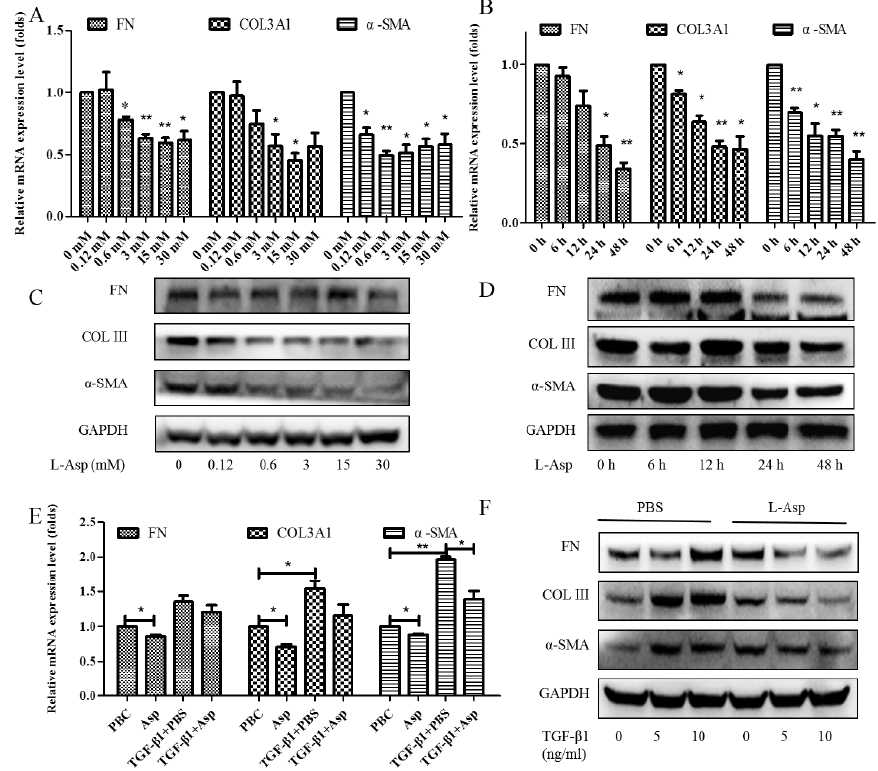
Figure 2. Inhibitory effect of Asp on HSCs activation in vitro. ( A – D ) LX-2 cells were treated with Asp in different concentrations or at different time. ( E , F ) LX-2 cells were treated with 5 ng/mL TGF- β1 for 24 h and then treated with Asp for another 24 h. ( A , B , E ) Real-time PCR was assessed to investigate mRNA level of α -SMA, COL Ⅲ , and FN. ( C , D , F ) Western blot was assessed to investigate the protein level of α -SMA, COL Ⅲ , and FN (n = 3). The results shown are the mean ± standard error. * p < 0.05, ** p < 0.01.